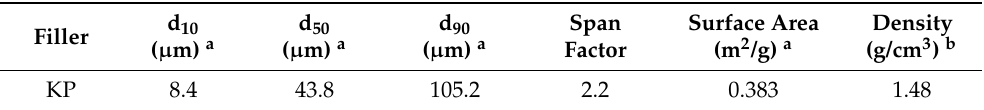
Table 2. The 10th percentile (d 10 ), 90th percentile (d 90 ), and median percentile (d 50 ) of particle size distribution, span factor, surface area, and density of KP.